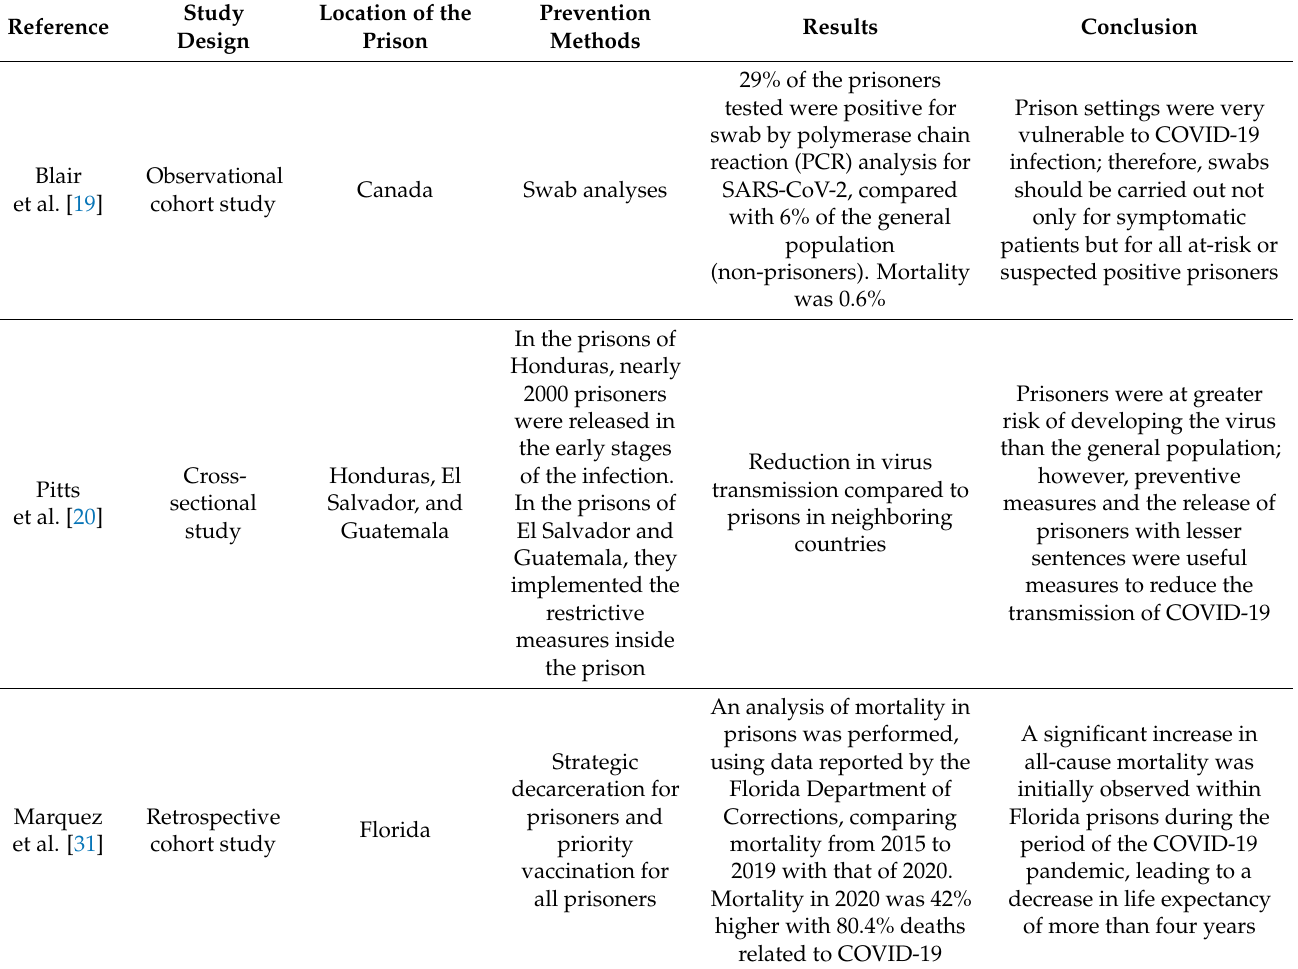
Table 1. Summary of the details of the systematic